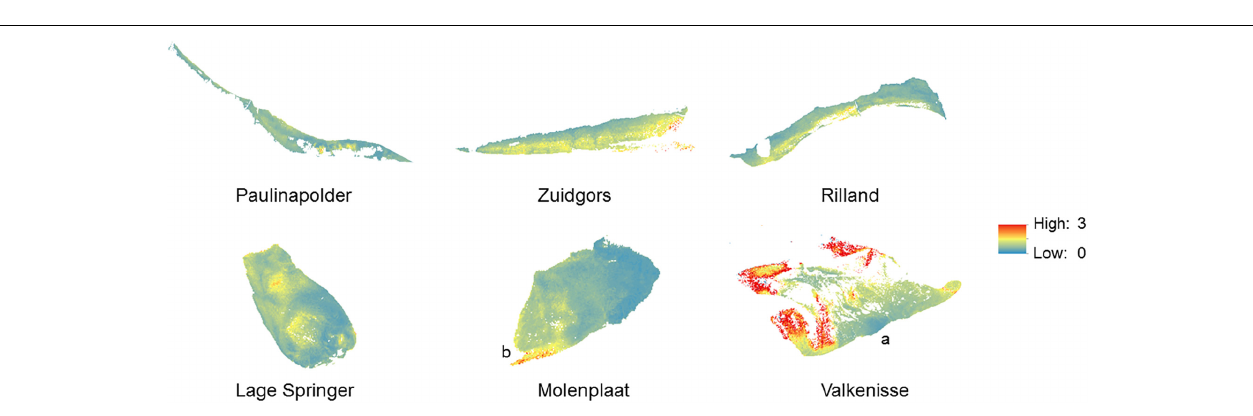
FIGURE 6 | NDVI maps averaged per season for ‘Lage Springer’ (mid-channel tidal flat) and ‘Paulinapolder’ (fringing tidal flat).